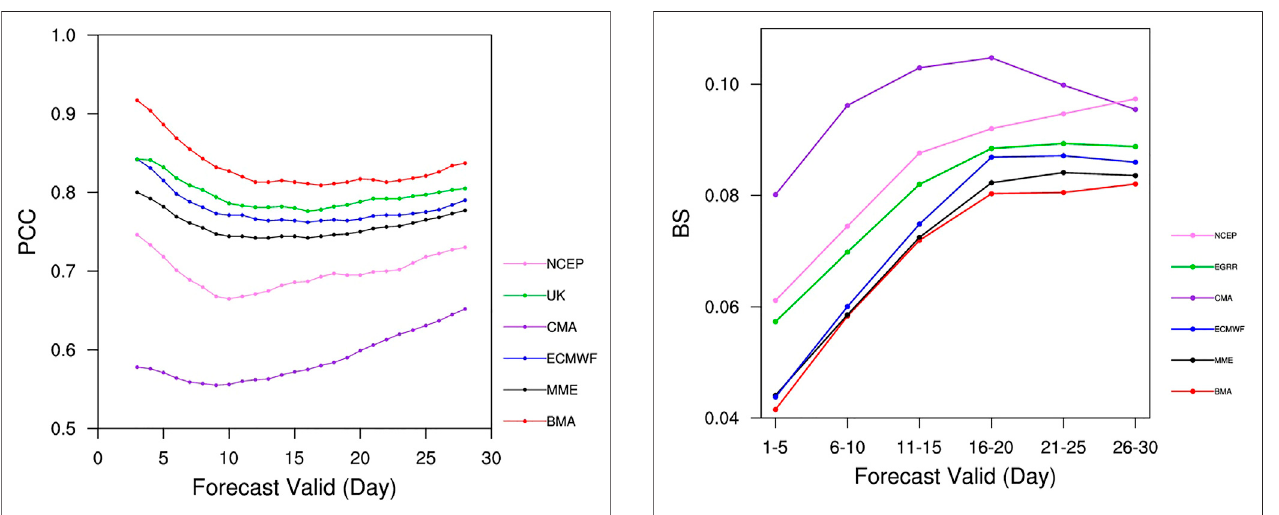
Frontiers in Earth Science |